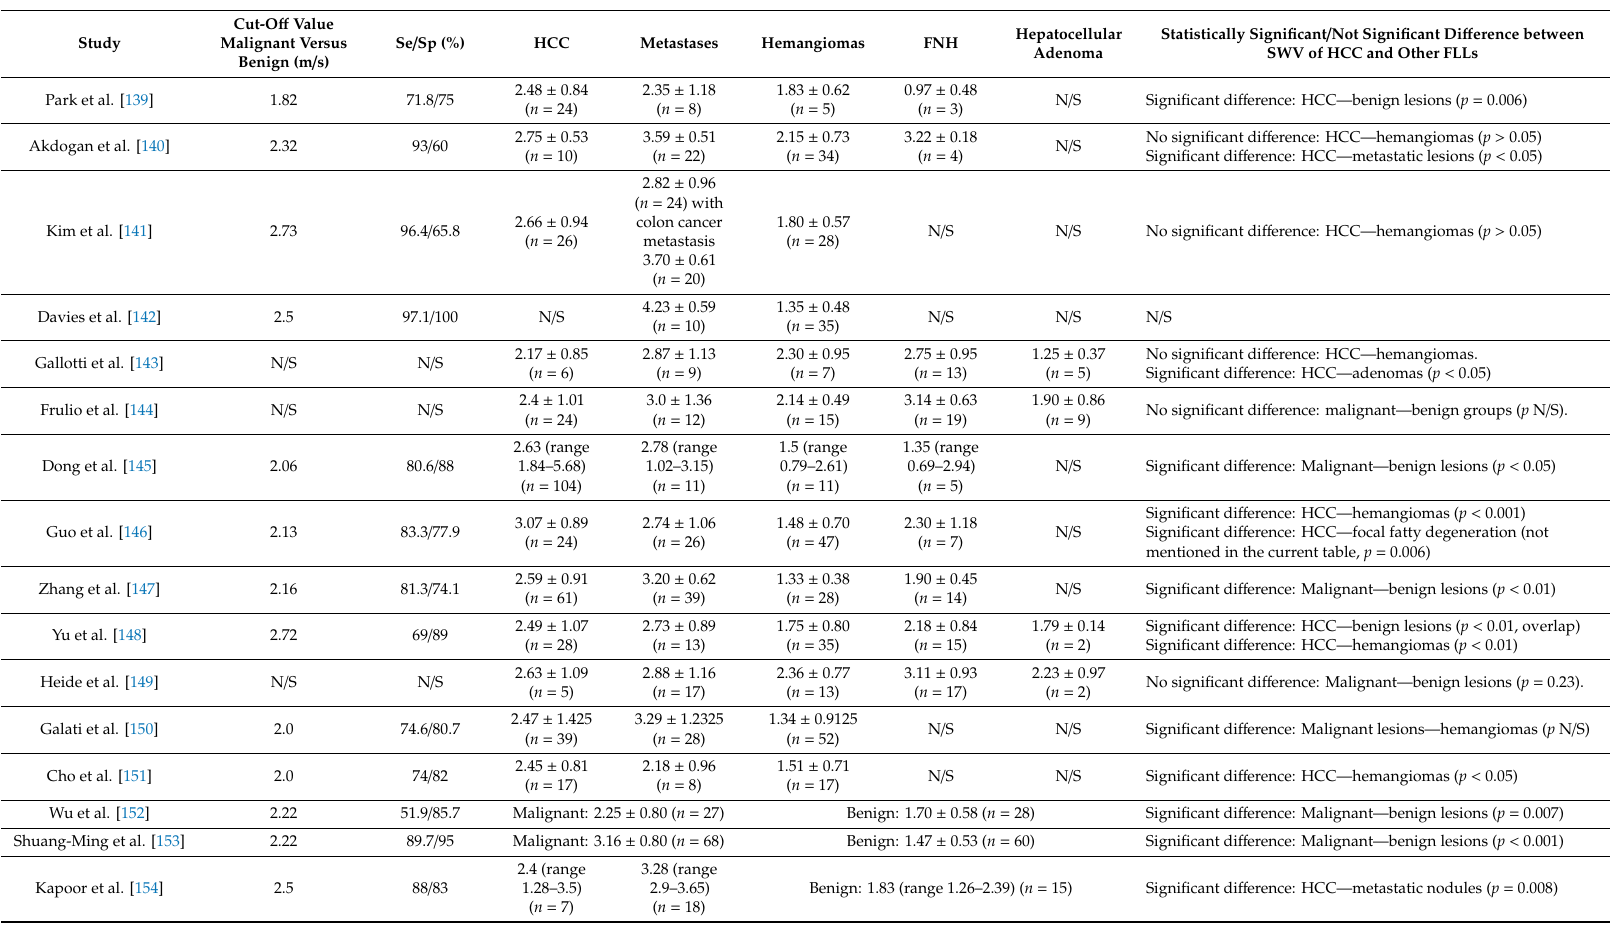
Table 5. A collection of shear wave velocity values (mean in m / s, range) for a predefined number of focal liver lesions (FLLs) in di ff erent studies, using the pSWE technology. The table includes the SWV cut-o ff values (m / s) for discriminating malignant versus benign FLLs, their corresponding sensitivity (Se) and specificity (Sp), as well as the statistical interpretation of the discrimination of HCC lesions from